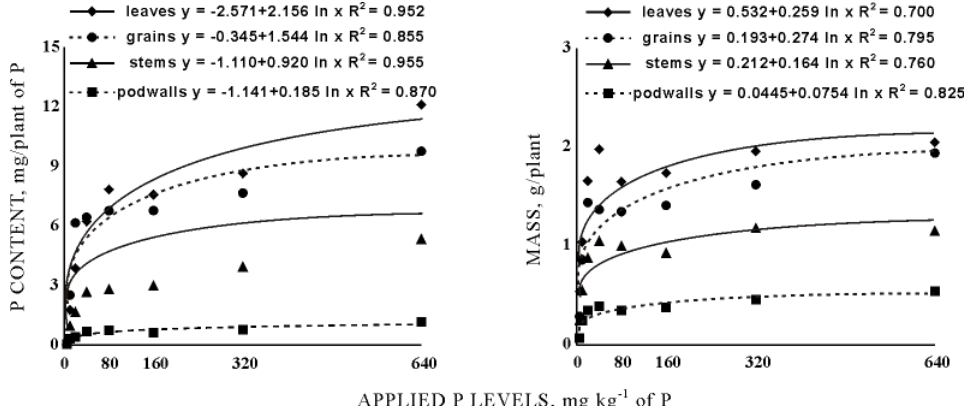
Figure 5. Dry mass and P accumulated in stems, pod walls and grains at maturity, and in senesced leaves totalized throughout the growth cycle, of common bean plants grown at eight P levels applied to the soil; points represent the experimental means, and lines the logarithmic model adjusted to the data.